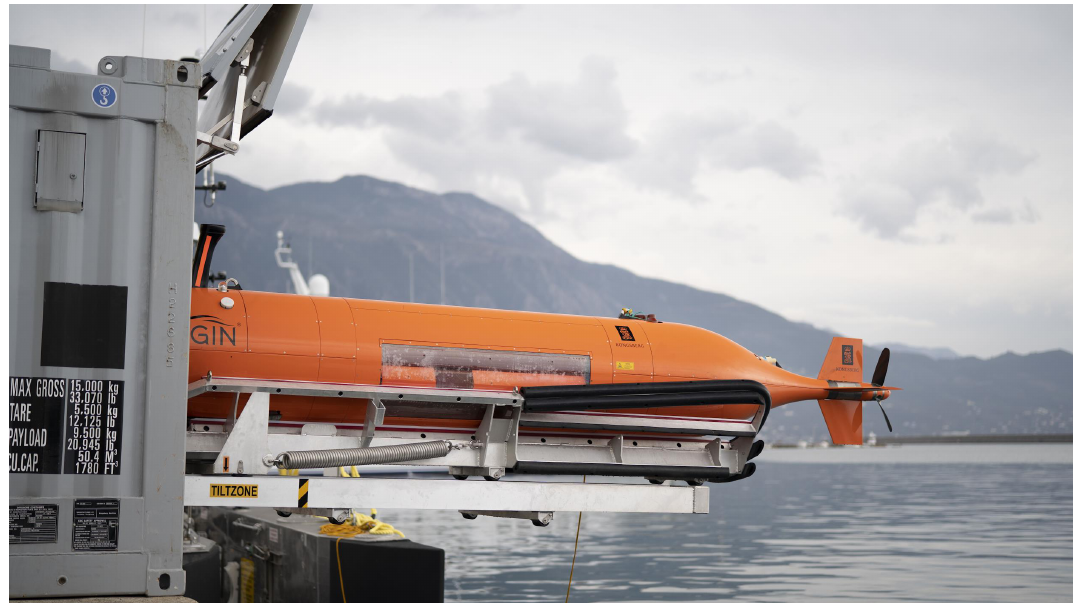
Figure 1. Autonomous Underwater Vehicle HUGIN during shore recovery: the underwater component of the mapping devices set used in Round 2 of Shell Ocean Discovery XPRIZE (Photography by